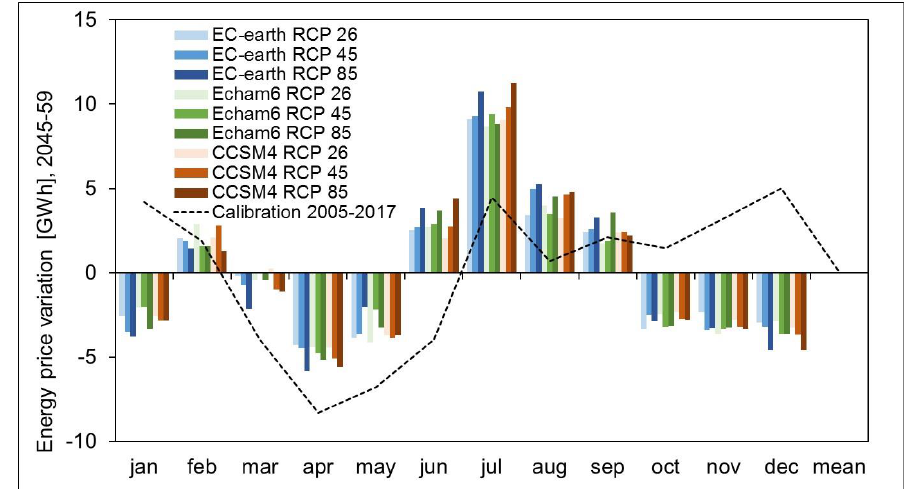
Figure 11. Sabbione reservoir. Projected mean monthly energy price relative to annual mean ( € / MWh), against the CR scenario for period P1 (2045–2059).